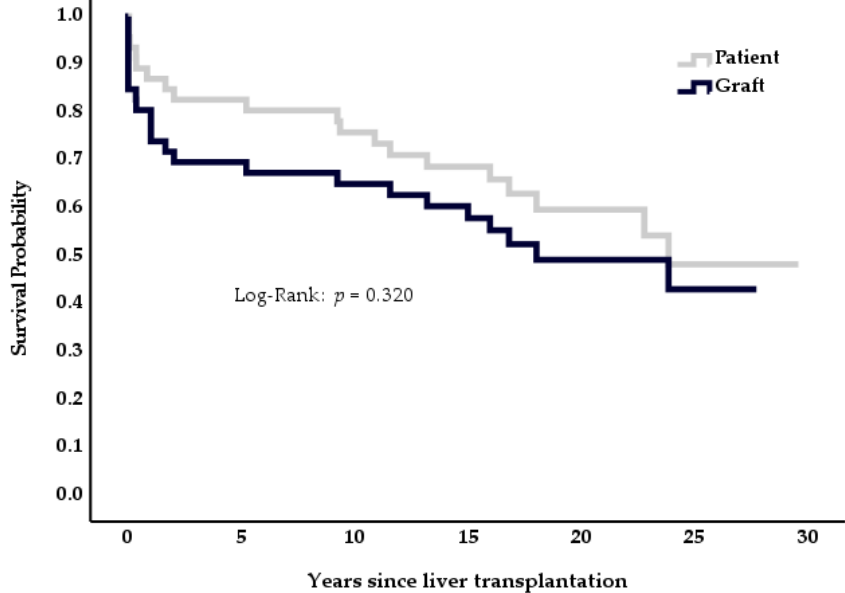
Figure 2. Cumulative graft and patient survival, patients with Budd Chiari syndrome ( n = 46). Graft losses occurred early after transplantation. Out of the eleven patients that needed a second transplant, only one was done 19 years after primary LT; all others were re-transplanted within the first three years after initial transplantation. Between 1989 and 2019, 2723 patients received a primary liver transplant at our center. The median survival after LT for patients with BCS ( n = 46) was 23.8 years, and 17.8 years for patients across all other indications ( n = 2677). Cumulative survival rates at 10 and 20 years were 76% and 65% and 60% and 46%, respectively. This difference did not reach statistical significance (Figure 3, p =